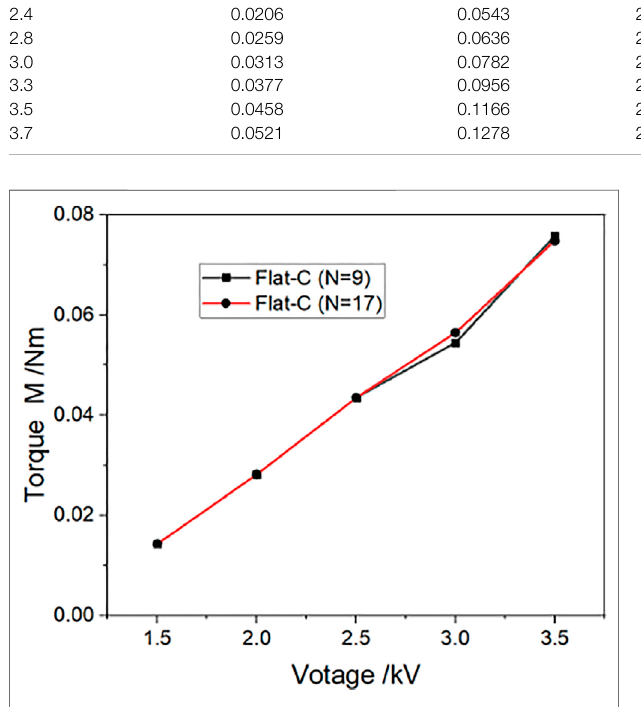
Frontiers in Materials |